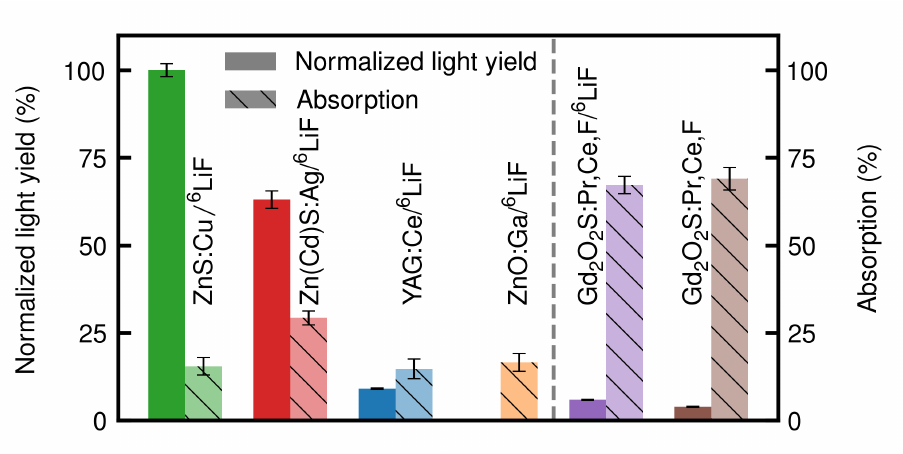
Figure 1. Neutron absorption of the six scintillation screen mixtures (hatched bars) and the resulting light yield (bars). The scintillation screens are split into two categories, the 6 LiF-based screens on left of the dashed line and the Gd-based screens on the right. The scintillation screens in one group were irradiated